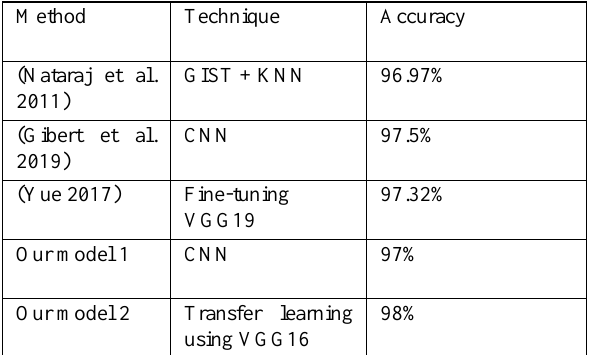
Table 3. Comparison of accuracy